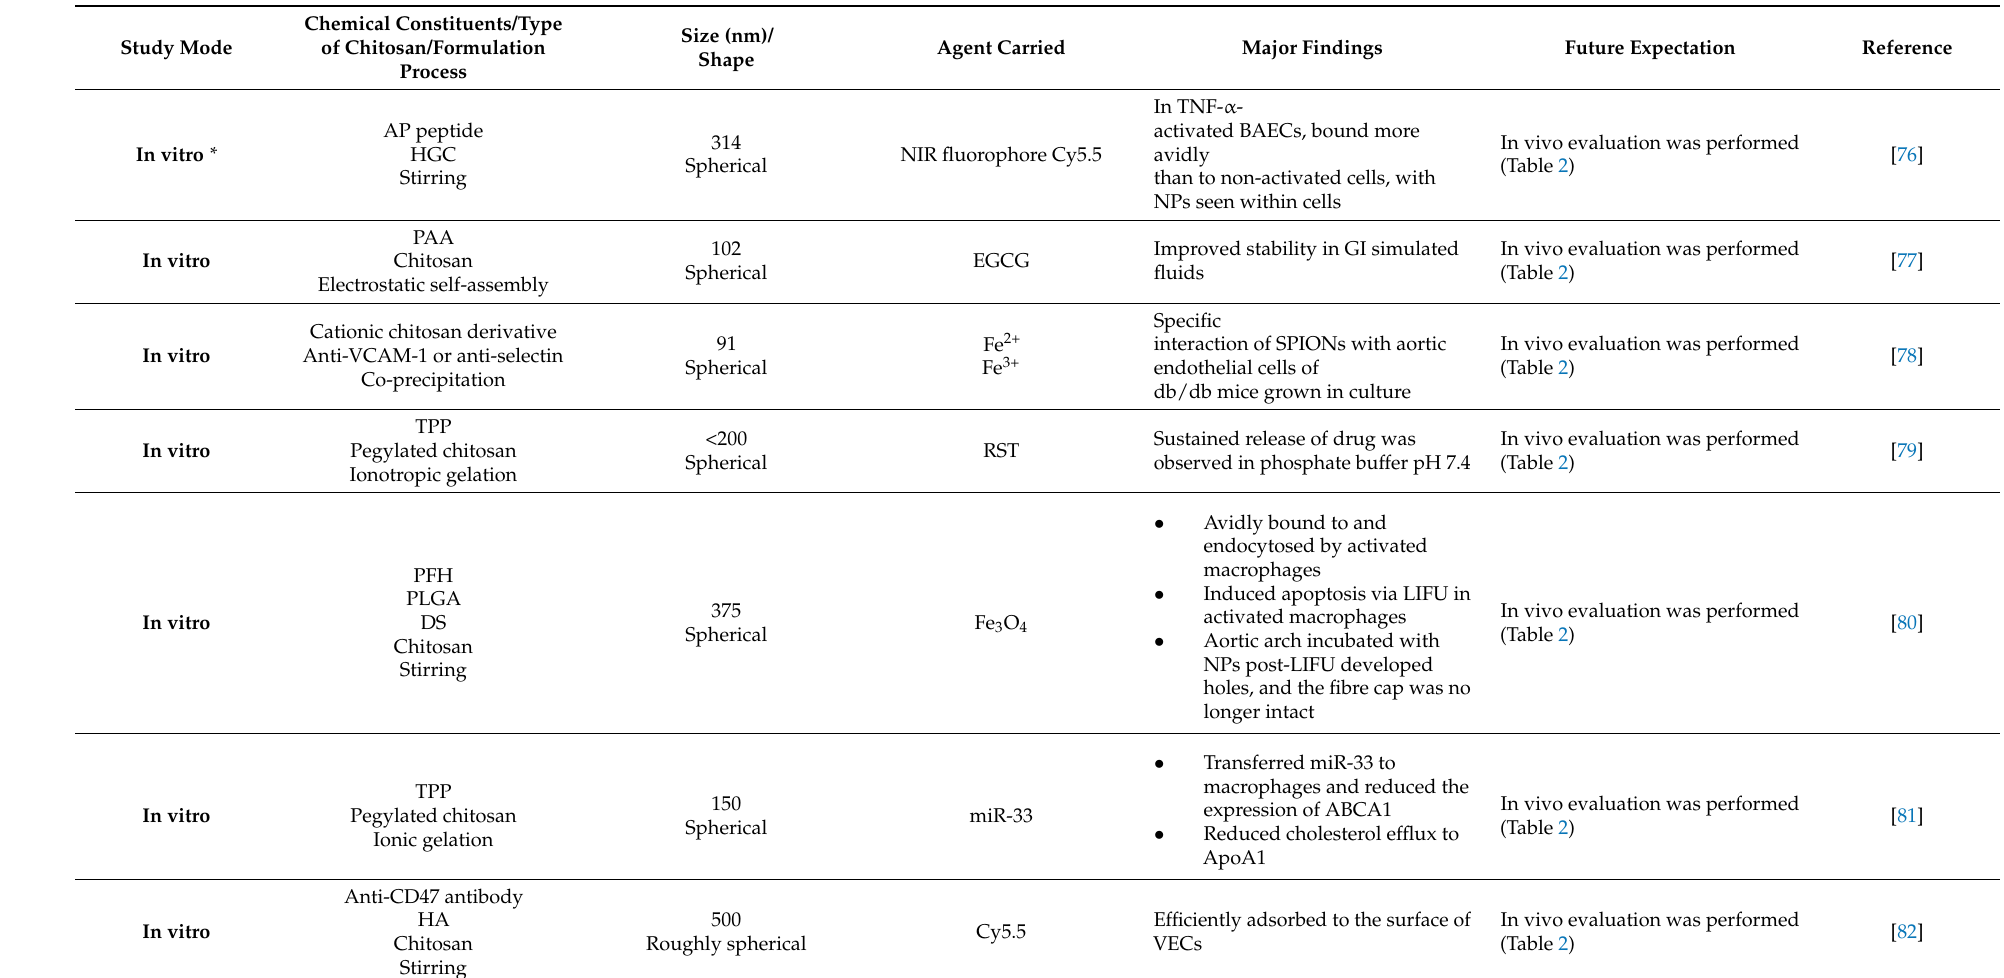
Table 1. Summary of studies using chitosan nanoparticles In vitro in atherosclerosis